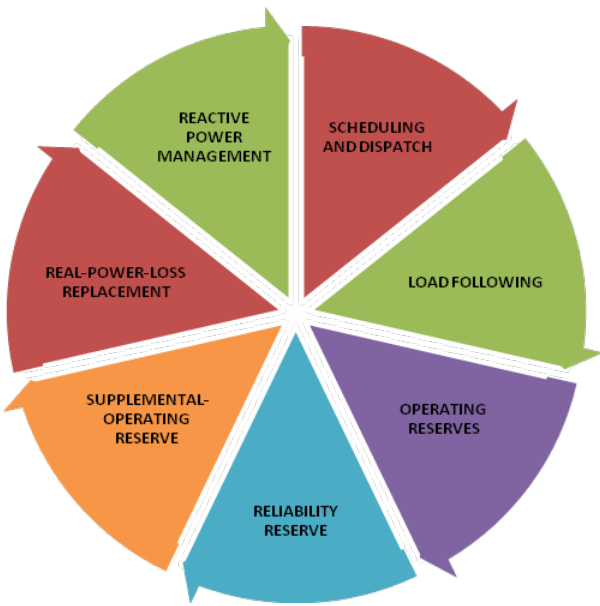
Figure 2. Popular ancillary services in electric power market suggested by FERC.